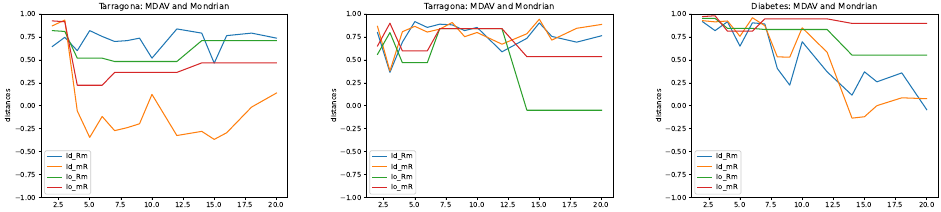
Figure 2. Rank correlation of mean Shapley values (_Rm) and mean correlation of Shapley values (_mR) for MDAV and Mondrian (letters d and o) using linear regression as the machine learning algorithm. Experiments with the Tarragona file were performed considered only the first 11 inputs ( left ), all 12 independent inputs ( middle ), and the Diabetes file ( right ).